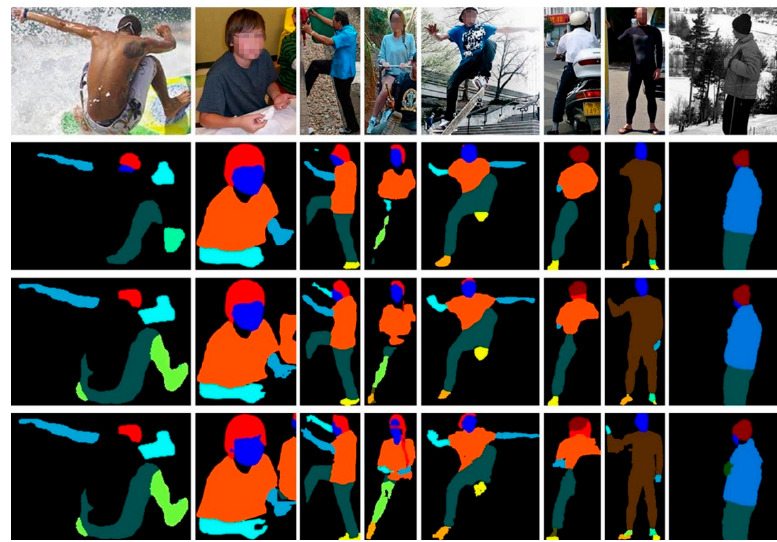
Figure 8. Performance comparison between the OM and the SM on the validation set. From the top row to the bottom row are input images, predictions from the SM, predictions from the OM and the ground truth labels. Appl. Sci. 2019 , 9 , x FOR PEER REVIEW